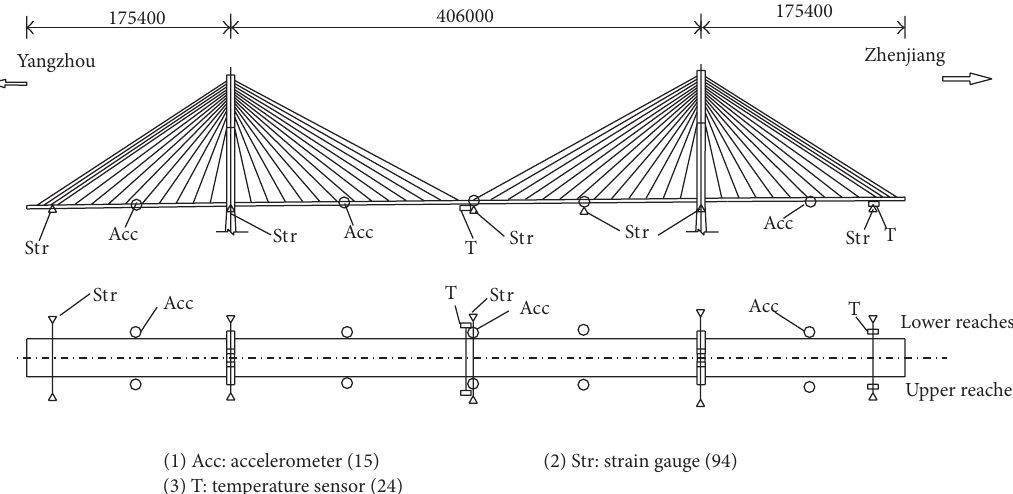
Figure 7: Layout of sensor system of RCB (dimension unit: